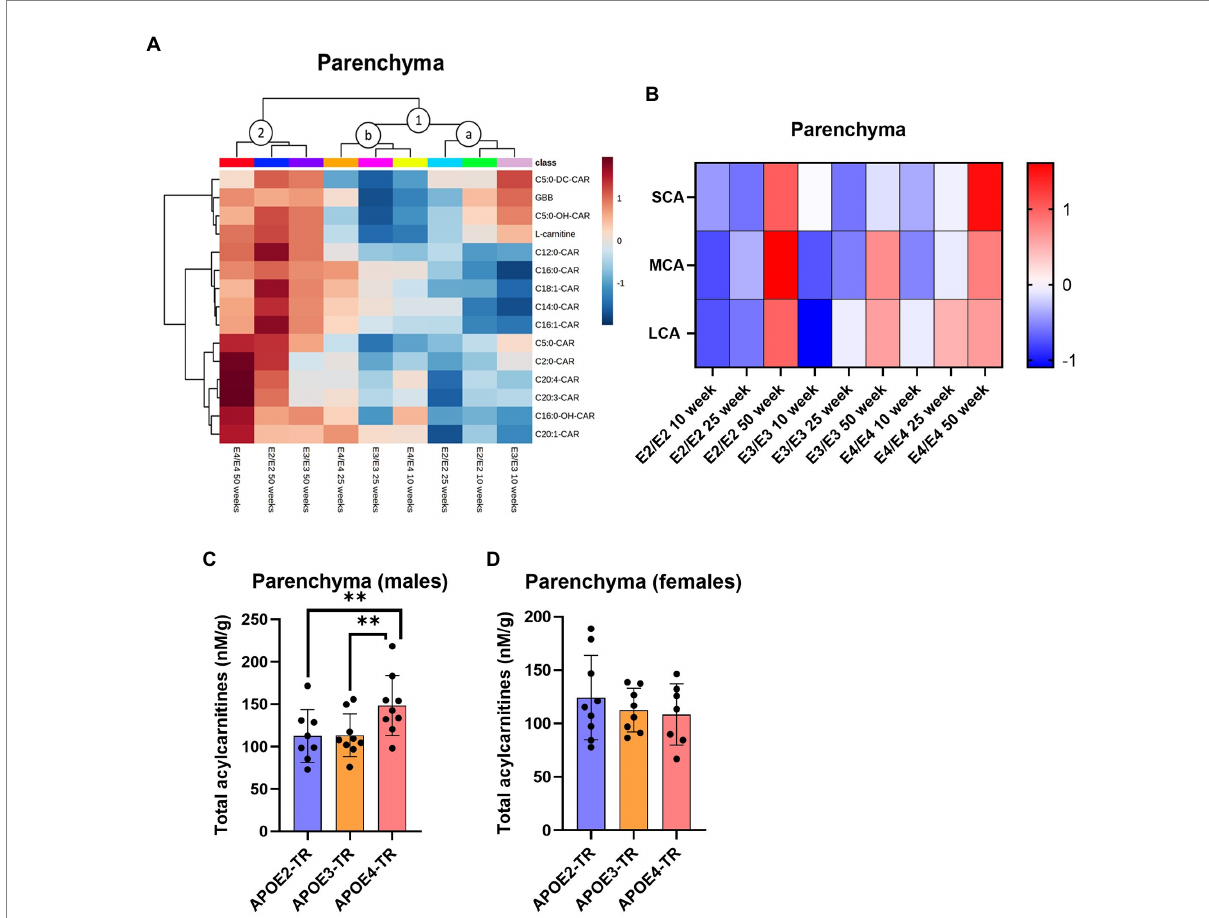
FIGURE 2 Age leads to increases in brain parenchymal acylcarnitines in an APOE -dependent manner. (A) Hierarchical clustering heatmap showing acylcarnitine species with APOE genotypes at different age timepoints in the brain parenchyma. (B) Z-score heatmap showing acylcarnitine chain length ratios to total acylcarnitines with APOE genotypes at different age timepoints in the brain parenchyma. (C) Bar graphs showing all points with mean ± SD total acylcarnitines in nM per gram of protein with APOE genotype in males in the brain parenchyma. (D) Bar graphs showing all points with mean ± SD total acylcarnitines in nM per gram of protein with APOE genotype in females in the brain parenchyma. Statistics: For the clustering heatmap data were normalized and scaled before being analyzed using Ward’s clustering, with the top 15 acylcarnitines selected by ANOVA. Multiple comparisons with B-H correction were performed on the data, * p < 0.05, ** p < 0.01, *** p < 0.001. Numbers per group; 10-week APOE2-TR n = 6, 25-week APOE2-TR n = 5, 50-week APOE2-TR n = 6, 10-week APOE3-TR n = 6, 25-week APOE3-TR n = 5, 50-week APOE3-TR n = 6, 10-week APOE4-TR n = 6, 25-week APOE4-TR n = 6, 50-week APOE4-TR n = 4, APOE2-TR (males) n = 8, APOE3-TR (males) n = 9, APOE4-TR (males) n = 9, APOE2-TR (females) n = 9, APOE3-TR (females) n = 8, APOE4-TR (females) n = 7. Cx:y-CAR, acylcarnitines; Cx:y-OH-CAR,